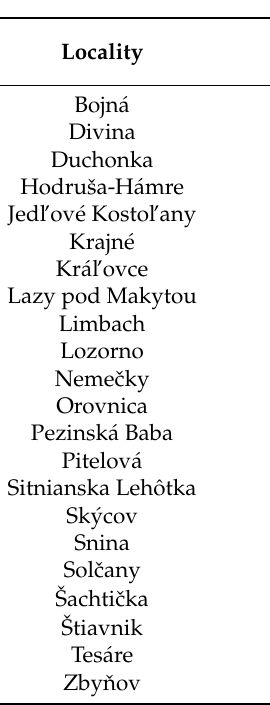
Table 1. Basic characteristics of the sampling areas.